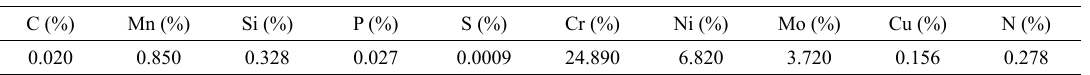
Figure 4. Transient temperature measurements and comparison with numerical predictions after thermophysical properties determination using inverse method (heat input =0.7 kJ mm -1 Table 2. Super duplex stainless steel (SDSS) chemical composition used.